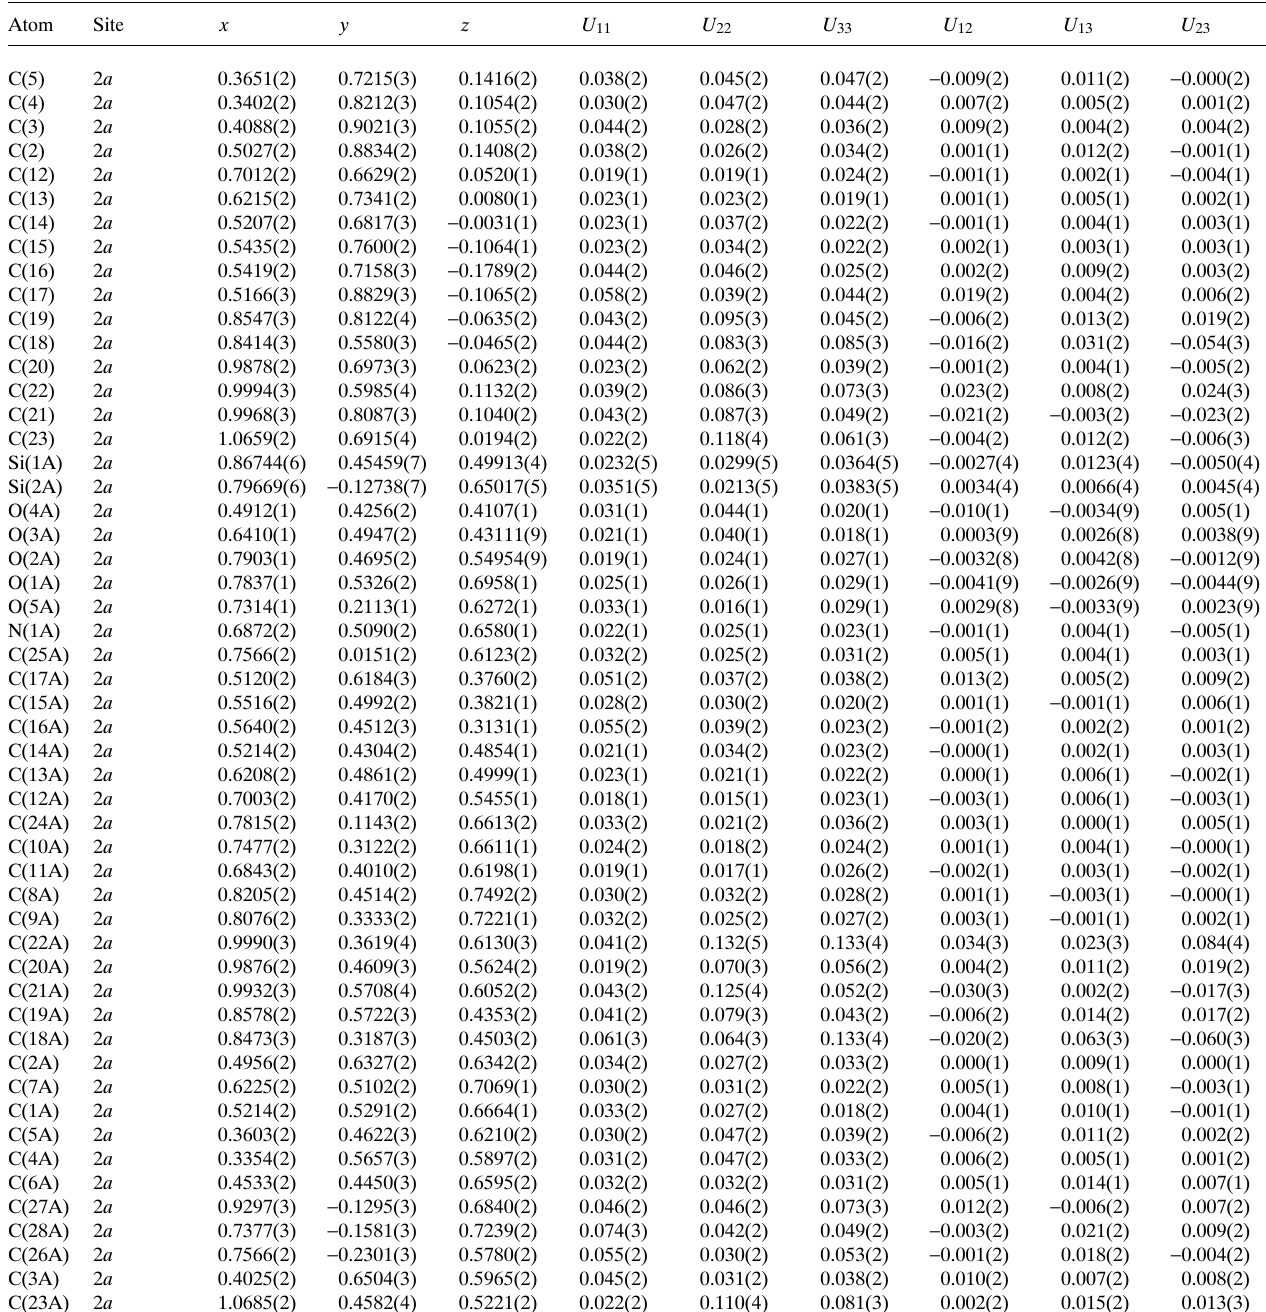
Table 3. C ontinued